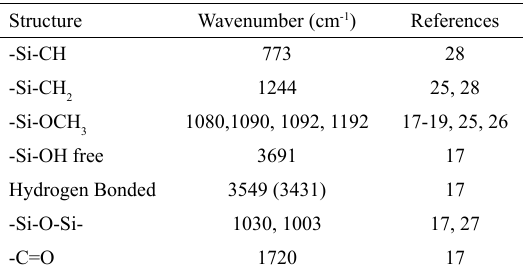
Figure 1. Silane crosslinking of polyethylene. Table 2. Absorption frequencies used to follow the crosslinking reactions of